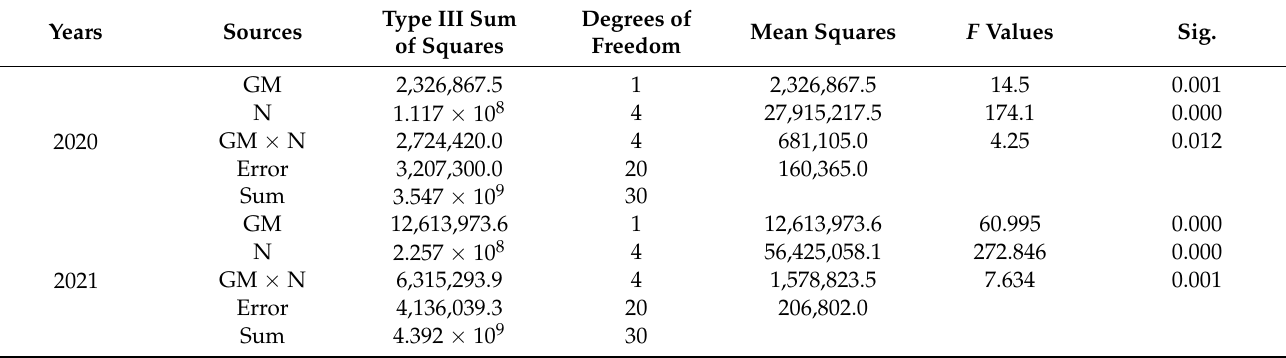
Figure 1. Spring maize grain yield (GY) response to N application under winter fallow (WF) and green manure return (GM) treatments in the North China Plain. Table 2. The ANOVA for GY under WF and GM treatments.